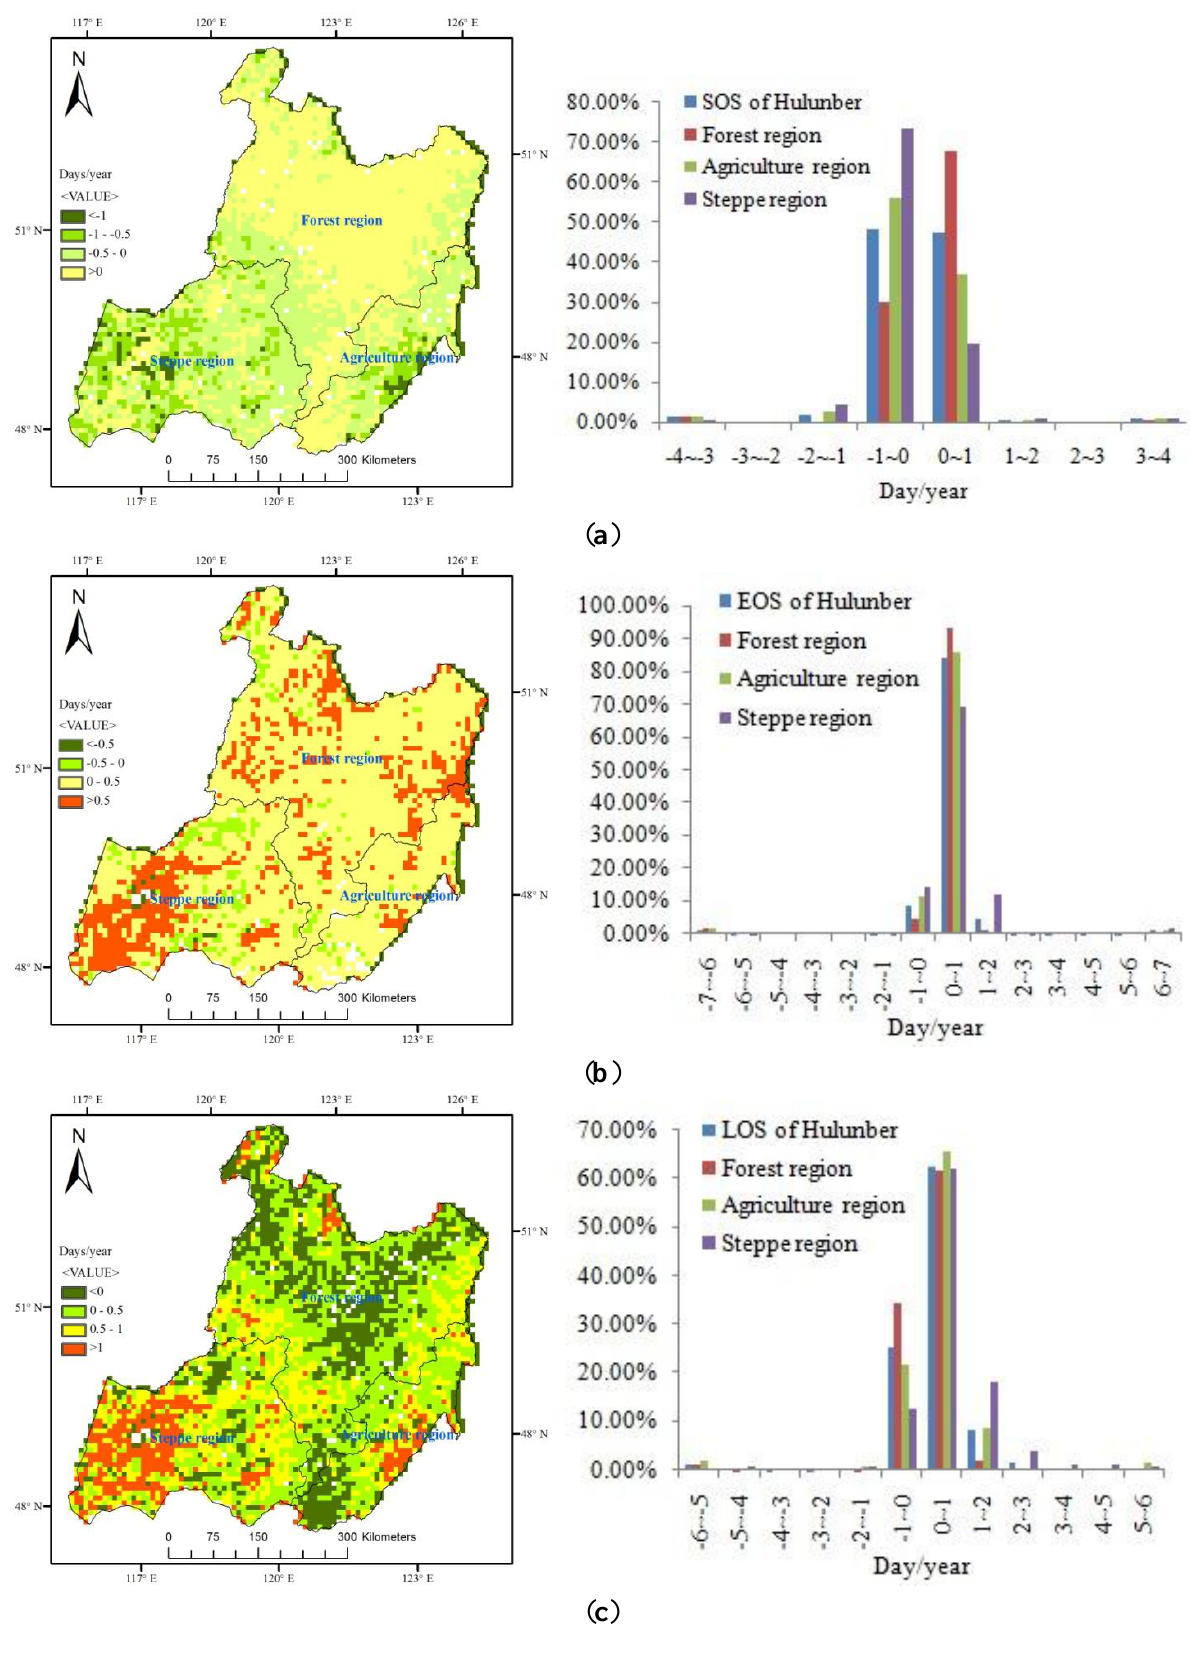
Figure 5. Spatial distributions of the variation ratio in Hulunber during 1982–2012. ( a ) SOS; ( b ) EOS; ( c )